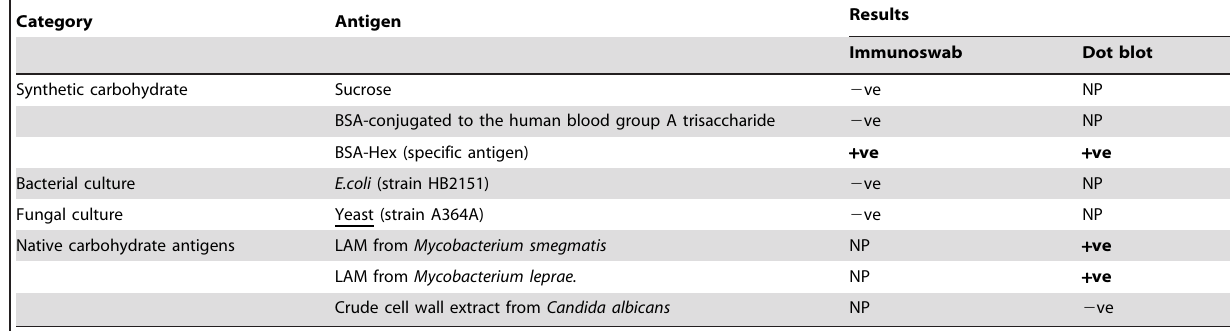
Table 2. Specificity study of the assay.